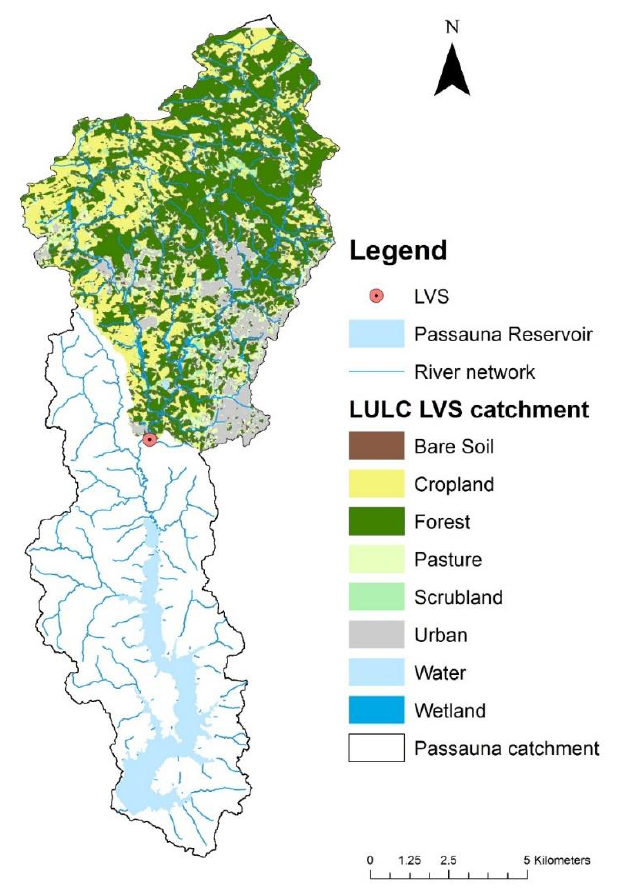
Figure 5. Location of the LVS and the land use/cover of its hydrological sub-catchment.